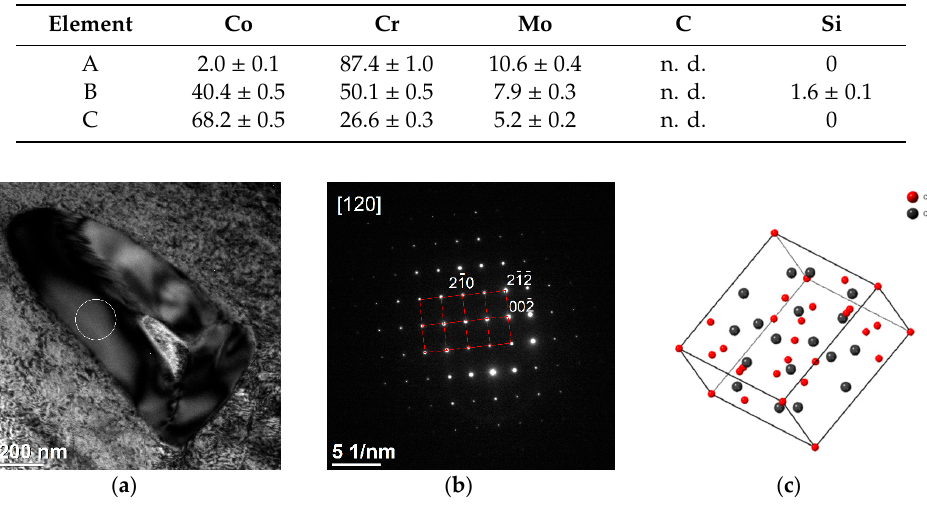
Figure 10. TEM image of selected precipitate in the Co-PIM sample ( a ). SAED electron diffraction of σ